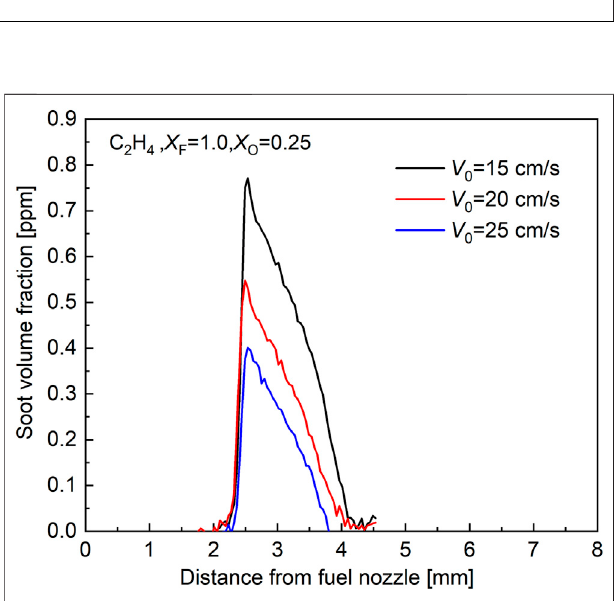
FIGURE 9 | Axial distribution of SVF with various X O .